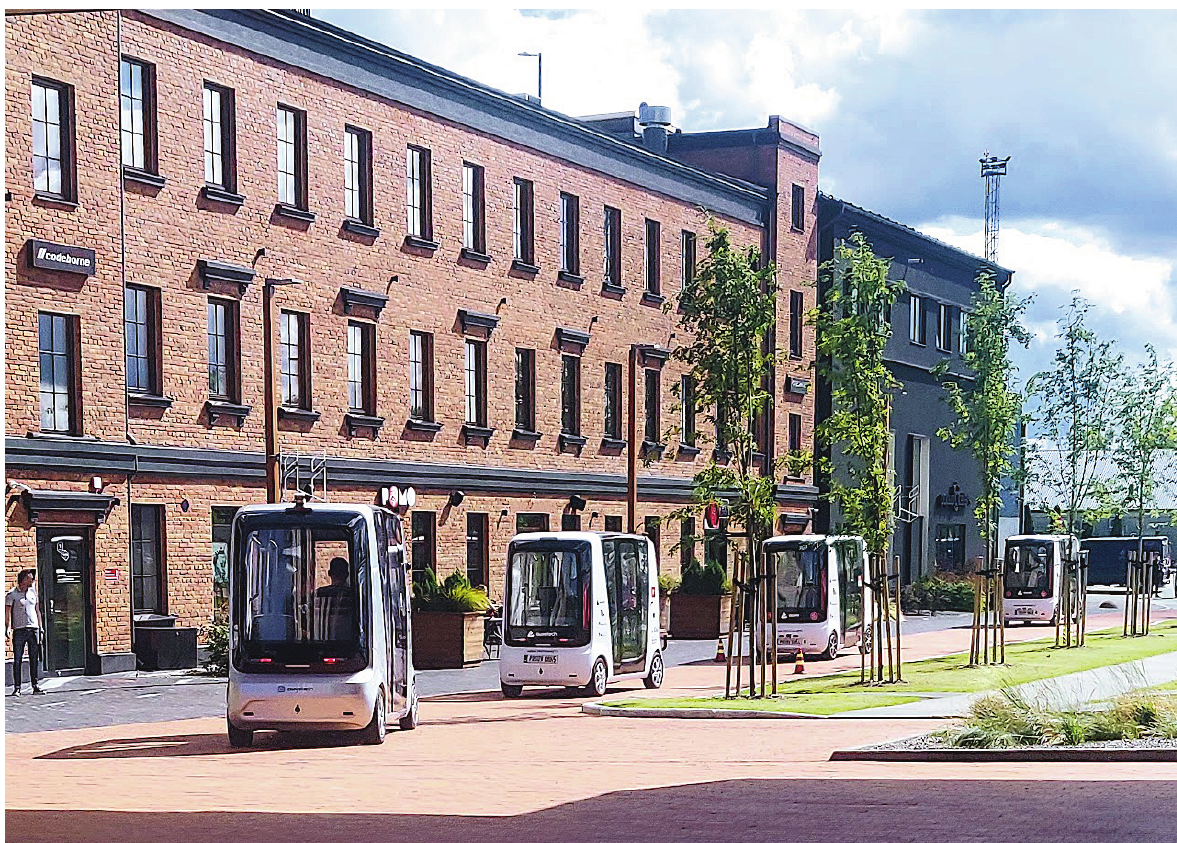
Fig. 3 . iseAuto AV shuttle deployment in Ülemiste